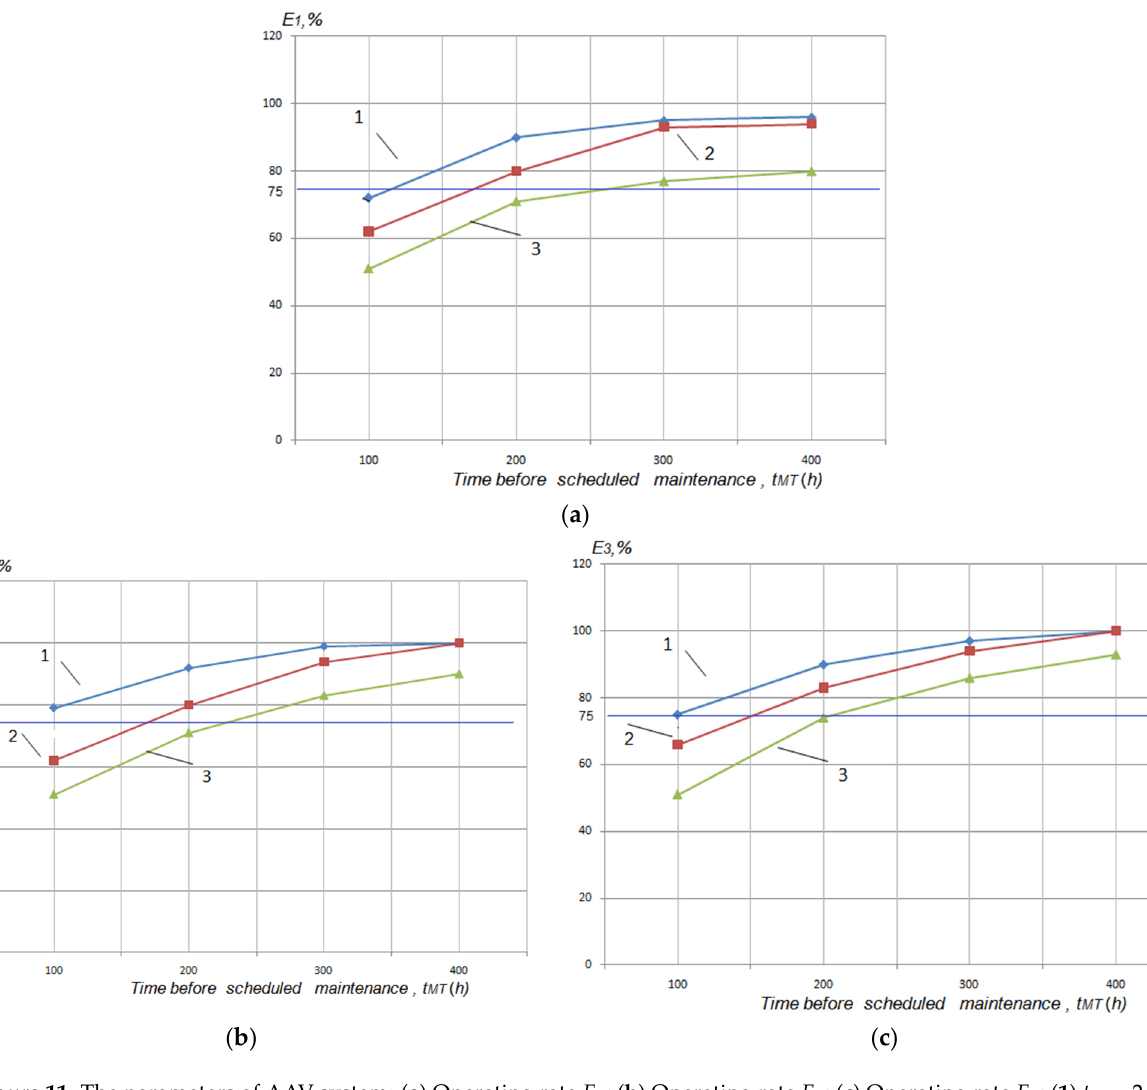
Figure 11. The parameters of AAV system: ( a ) Operating rate E 1 ; ( b ) Operating rate E 2 ; ( c ) Operating rate E 3 ; ( 1 ) t M = 24 h; ( 2 ) t M = 48 h; ( 3 ) t M = 72 h.